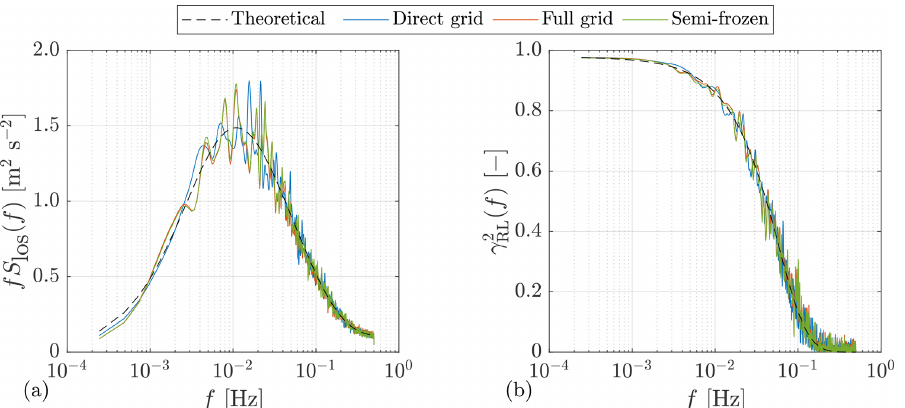
Figure 12. Comparison of the simulated lidar spectral properties with different grids. (a) Auto-spectra of LOS measurements. (b) Coherence between rotor effective wind speed (REWS) and lidar-estimated REWS. Direct grid: all the points required for lidar simulations are directly defined in the 4D wind field generation. Full grid: the vertical planes with regular grid points at the x positions of the focus points and the discrete volumes of the lidar range gates. Semi-frozen: the vertical planes with regular grid points at the x positions of the focus points of the lidar range gates. Beam azimuth angle: 15.0 ◦ . Beam elevation angle: 12.5 ◦ . Range gate: 87m. The simulated auto-spectra are averaged with 16